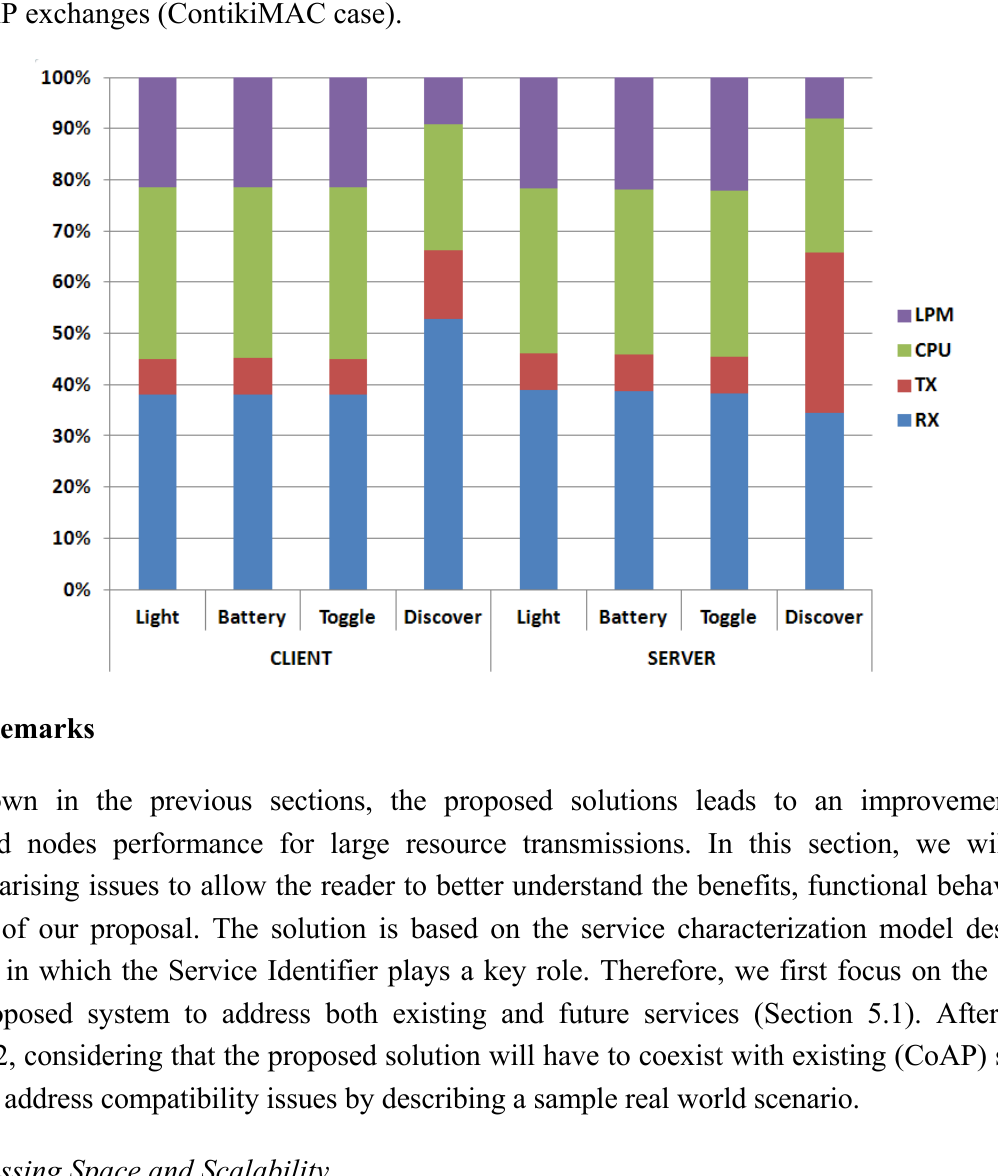
Figure 9. Energy Consumption percentage distribution among the reception (RX), transmission (TX), processing (CPU), low-power-mode (LPM) components for different CoAP exchanges (ContikiMAC